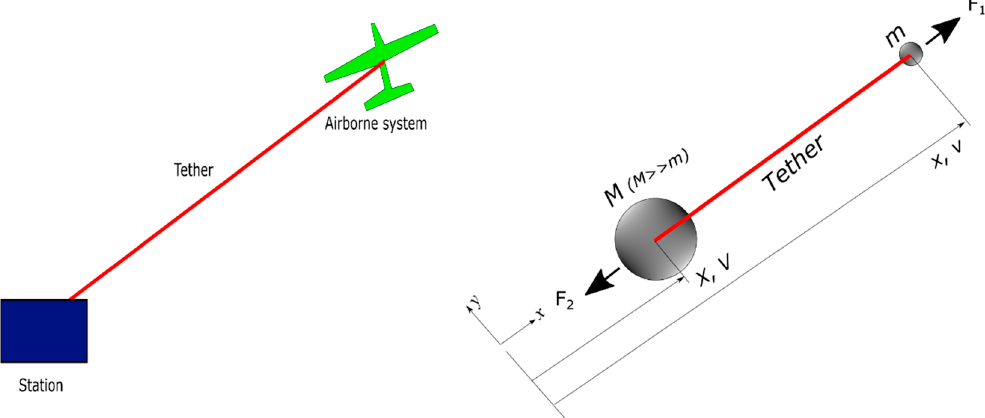
Figure 4. Simplified AWES model connected with a composite tether.